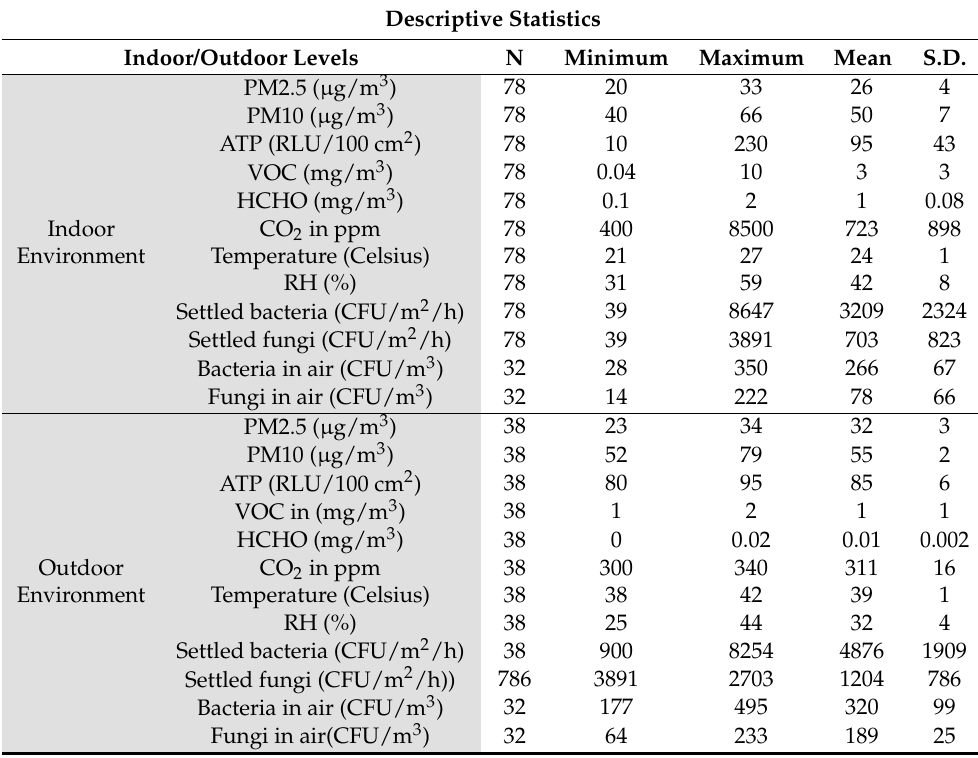
Table 1. Descriptive statistics about the environmental quality parameters measured in this study. Descriptive